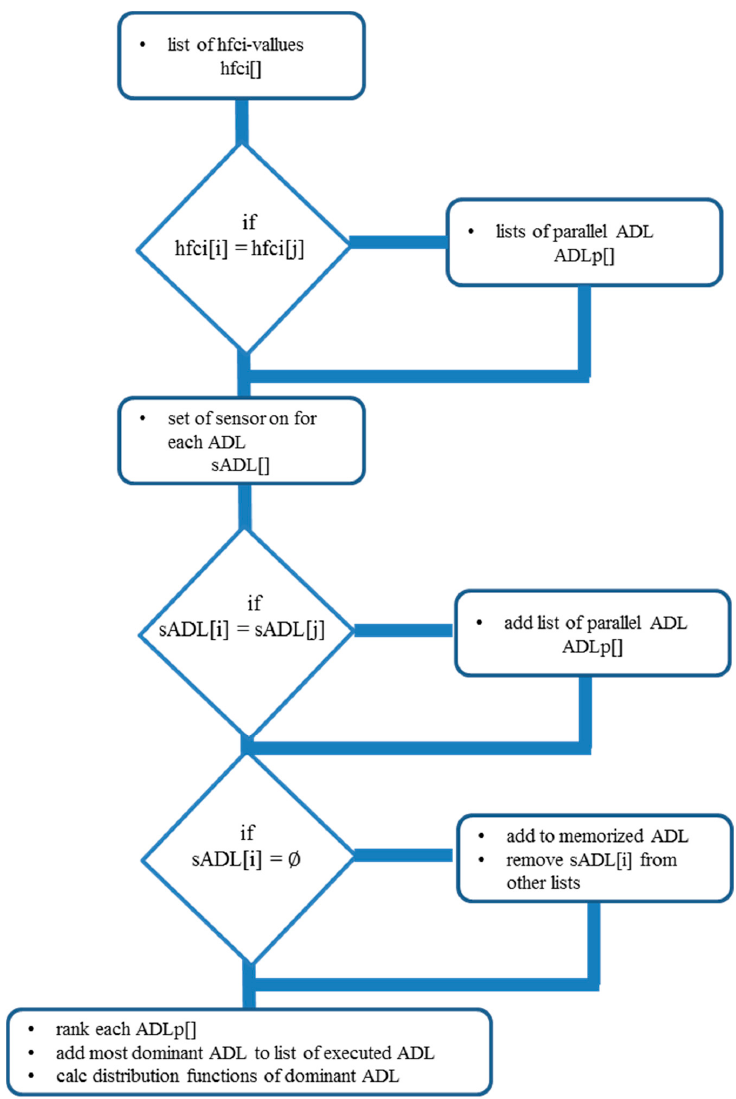
Figure 6. Abstract algorithm for the ADL detection. This chart shows the steps for the detection of parallel ADL.